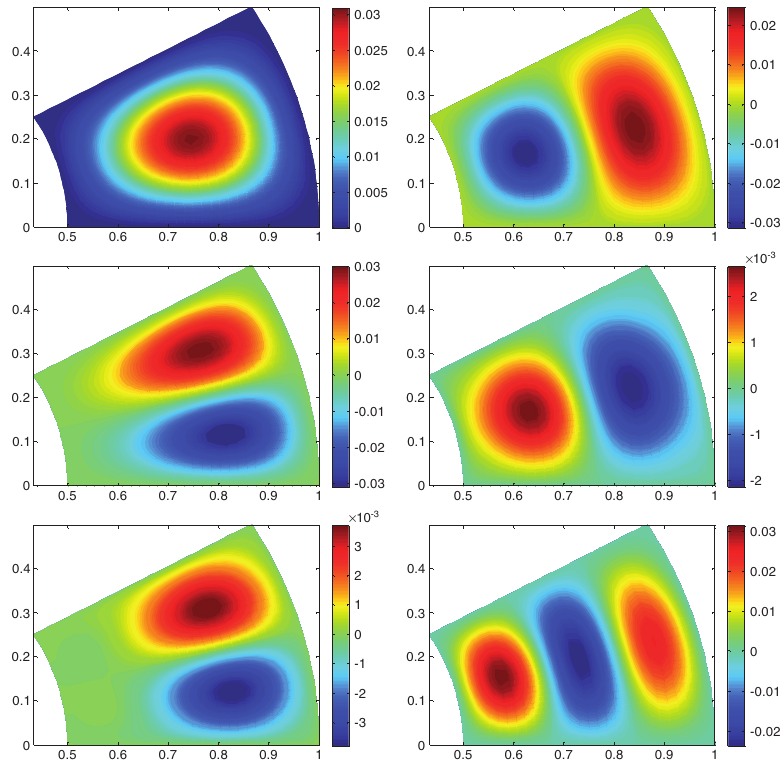
Figure 2 The first six mode shapes of a fully clamped isotropic FG annular sector plate for n = 1 and θ = 30 ° .